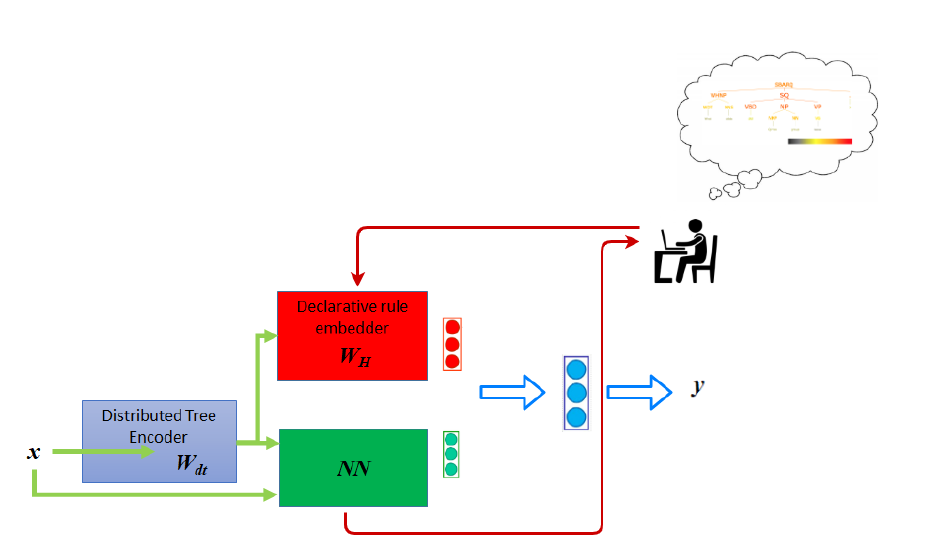
Figure 2. Pat-in-the-Loop : the overall